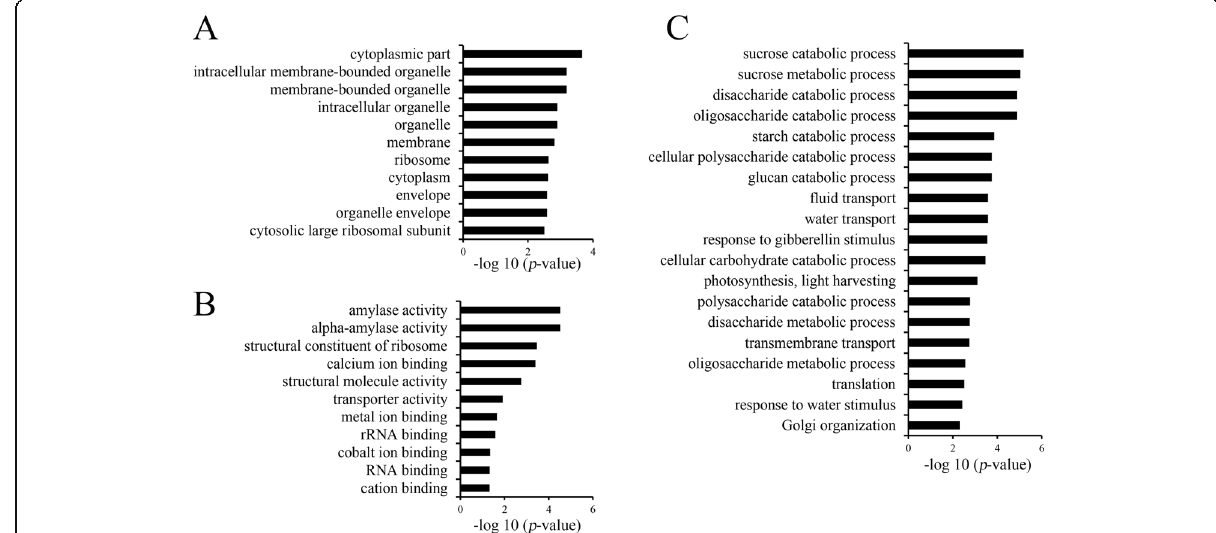
Fig. 4 Gene Ontology (GO) analysis for differentially expressed proteins (DEPs). a , The 11 significant cellular component GO terms of the DEPs. b , The 11 molecular function GO terms of the DEPs. c , The 19 significant biological process GO terms of the DEPs